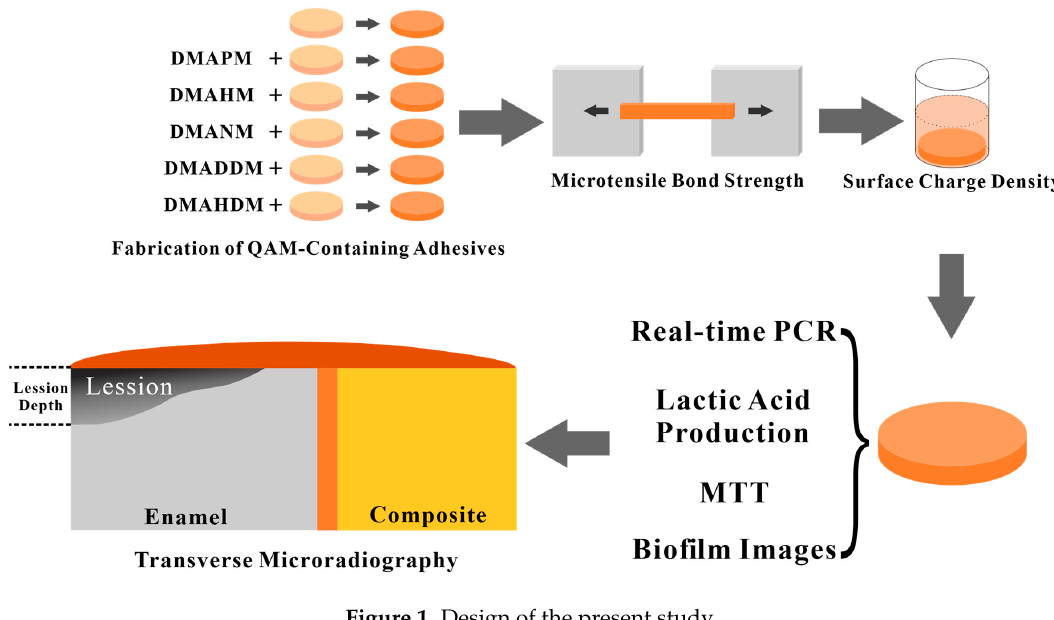
Figure 1. Design of the present study.